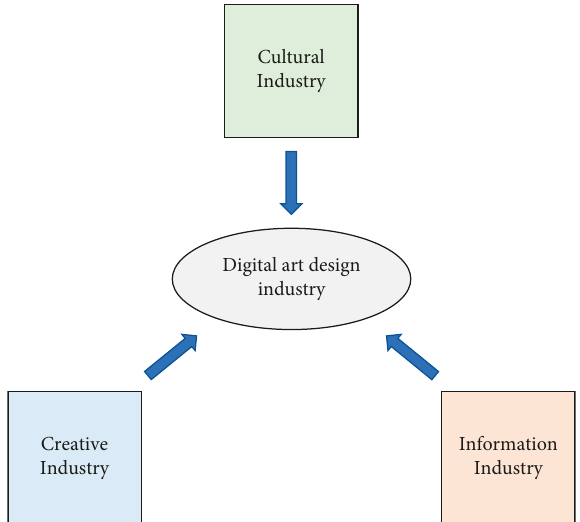
Figure 1: Component of digital art design